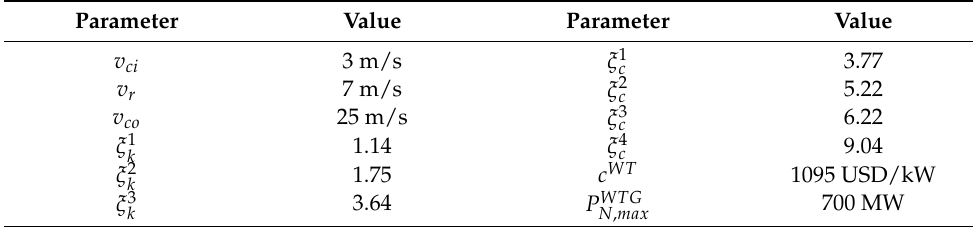
Table 2. Parameters of the wind turbine generator to be planned.